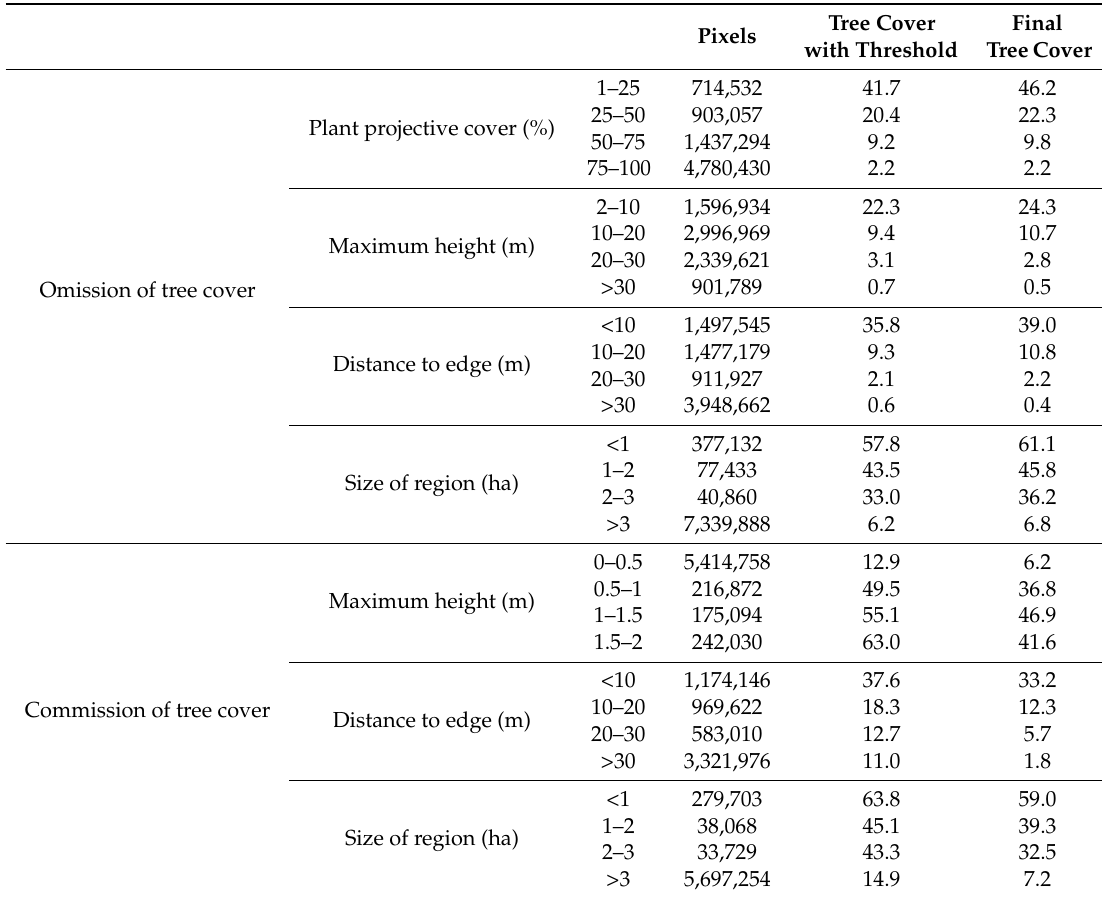
Table 2. Accuracy statistics for the binary tree cover map derived from multi-temporal SPOT5 imagery using lidar derived products as reference data. Tree cover with threshold represents the binary classification of the probability surface using manual thresholds, while final tree cover represents the edited map. The statistics reveal that the manual editing was focused on removing tree commission errors, which were significantly reduced.